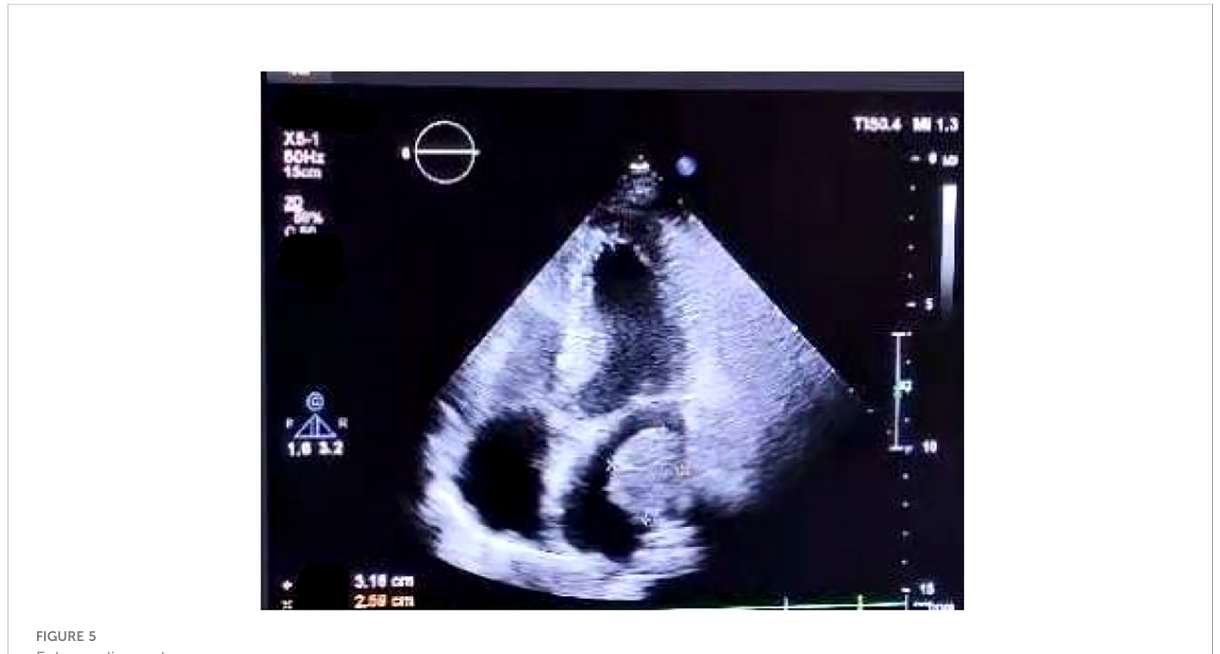
FIGURE 5 Echocardiography.